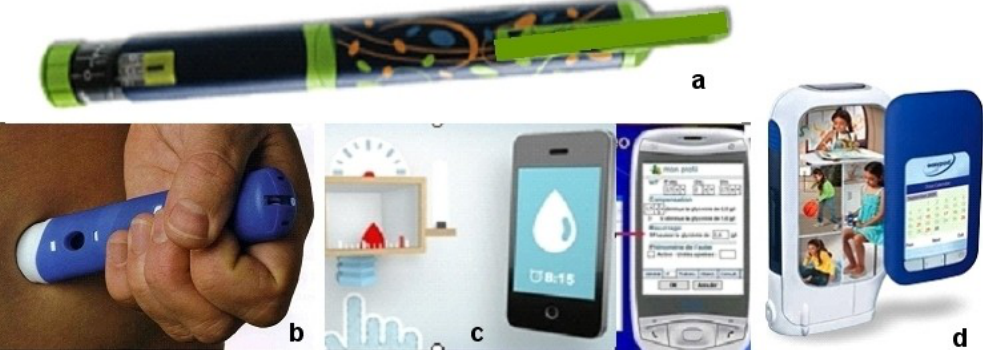
Figure 8. Example for injectable forms